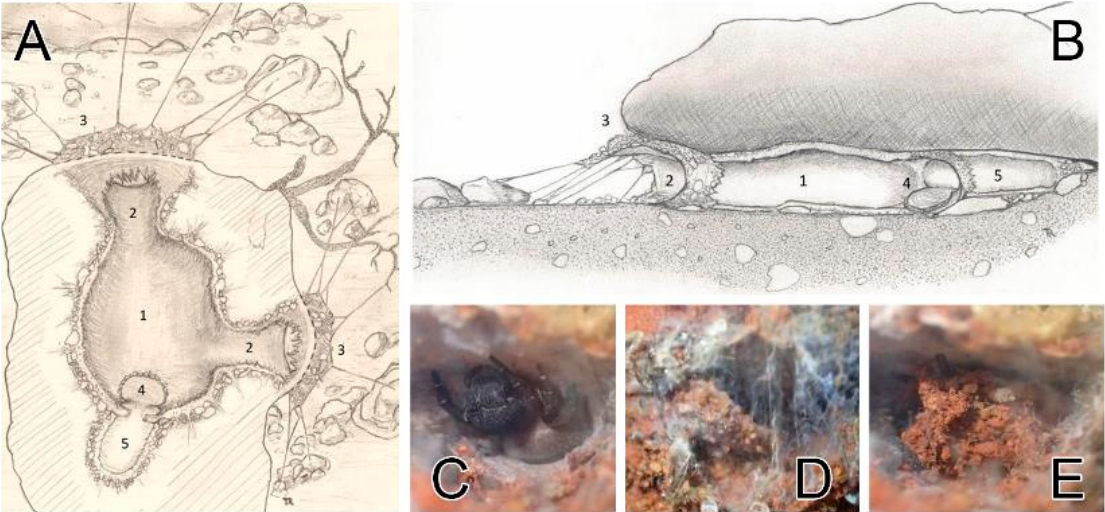
Figure 10. Retreats of Loureedia colleni from Spain. ( A , B ) retreat layout, dorsal and lateral views (illustration: Thomas Romanoff); ( C ) female with the open hatch; ( D ) hatch being closed; ( E ) closed hatch. Legend ( A , B ): 1 —main lodge; 2 —external access tunnels; 3 —hunting canopy and radial silk lines; 4 —“retreat” hatch; 5 —annex “retreat” lodge.